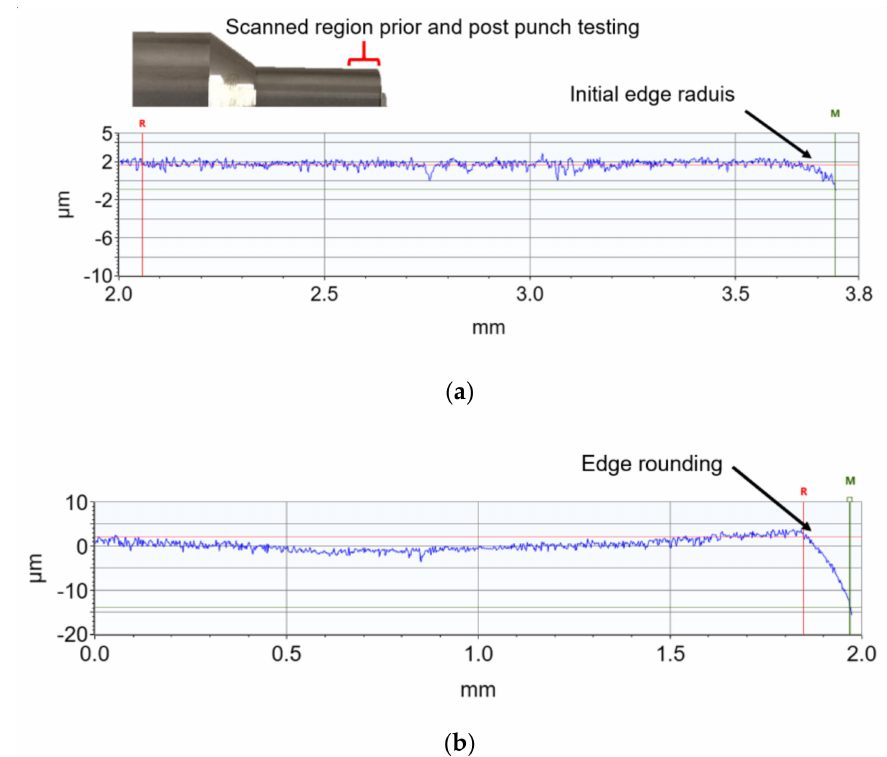
Figure13. 3DprofilometeranalysisoftheVSCpunch: ( a )unwornpriortopunchingtestingand( b )worn punch after 100,000